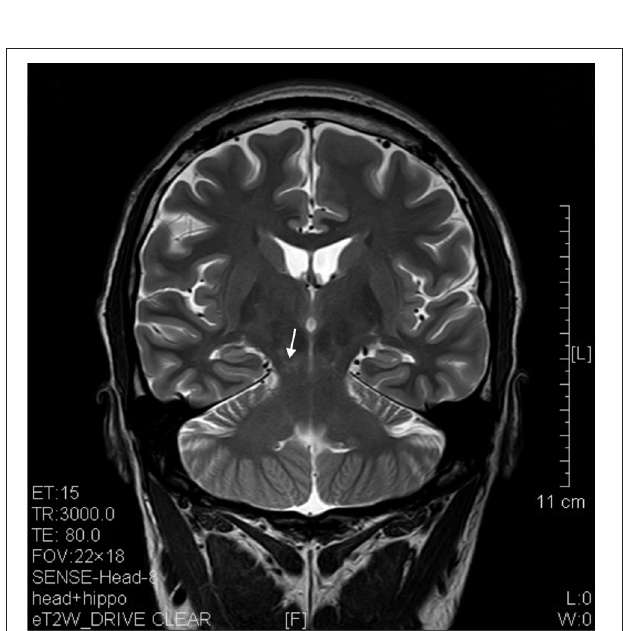
FIGURE 9 | T2 image of a coronal section that showed degenerative lesion (arrow) in the brainstem (midbrain) of a ketamine addict of 7